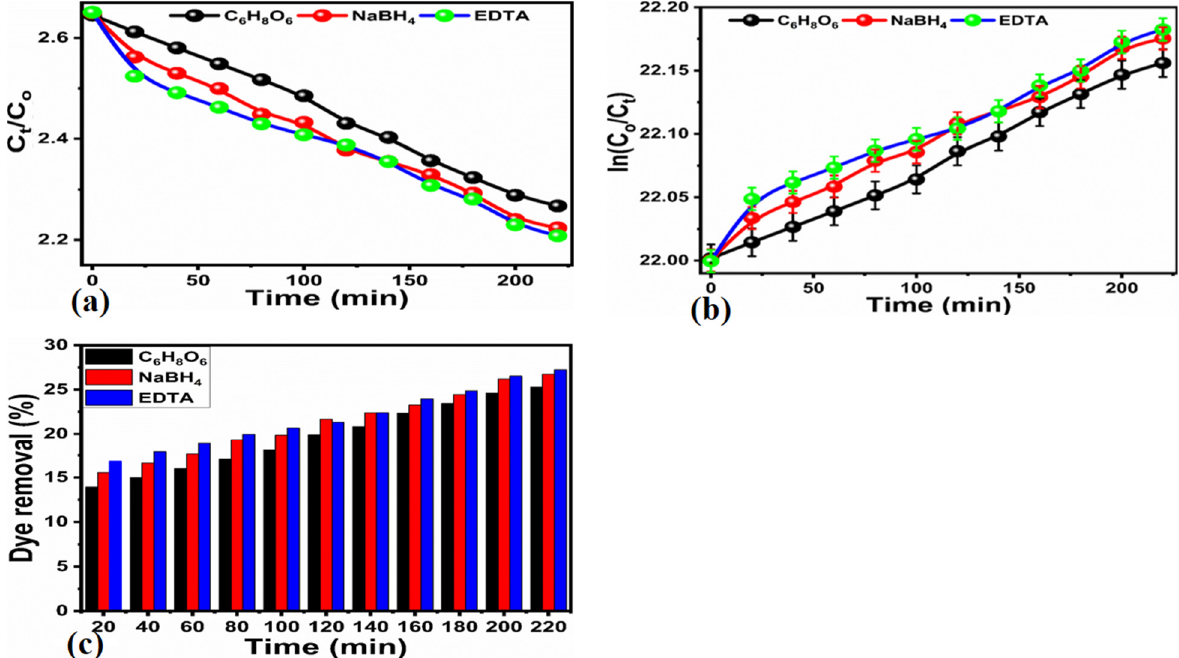
Table 3. The comparative analysis of present work with published work.